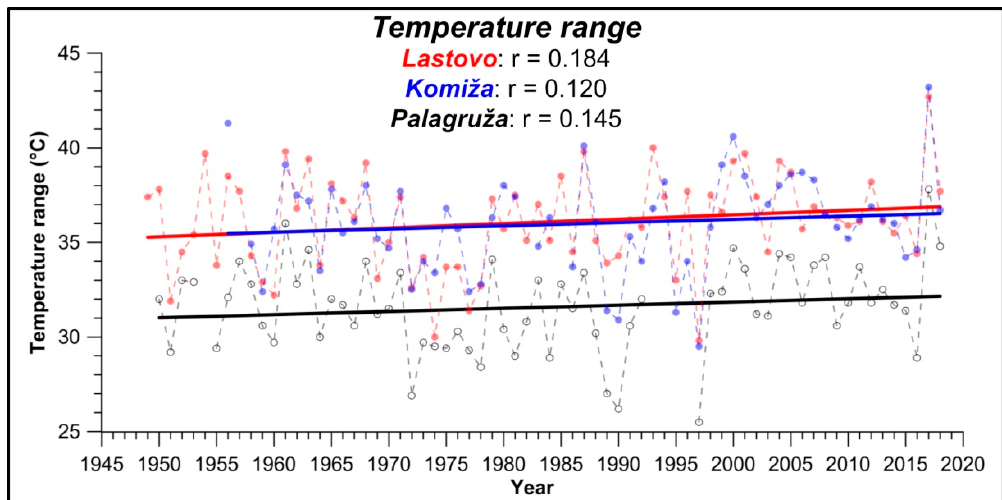
Figure 3. Annual air temperature ranges at Komiža, Lastovo, and Palagruža. The range was calculated subtracting the minimum annual temperature from the maximum annual temperature. r is the linear correlation coefficient.